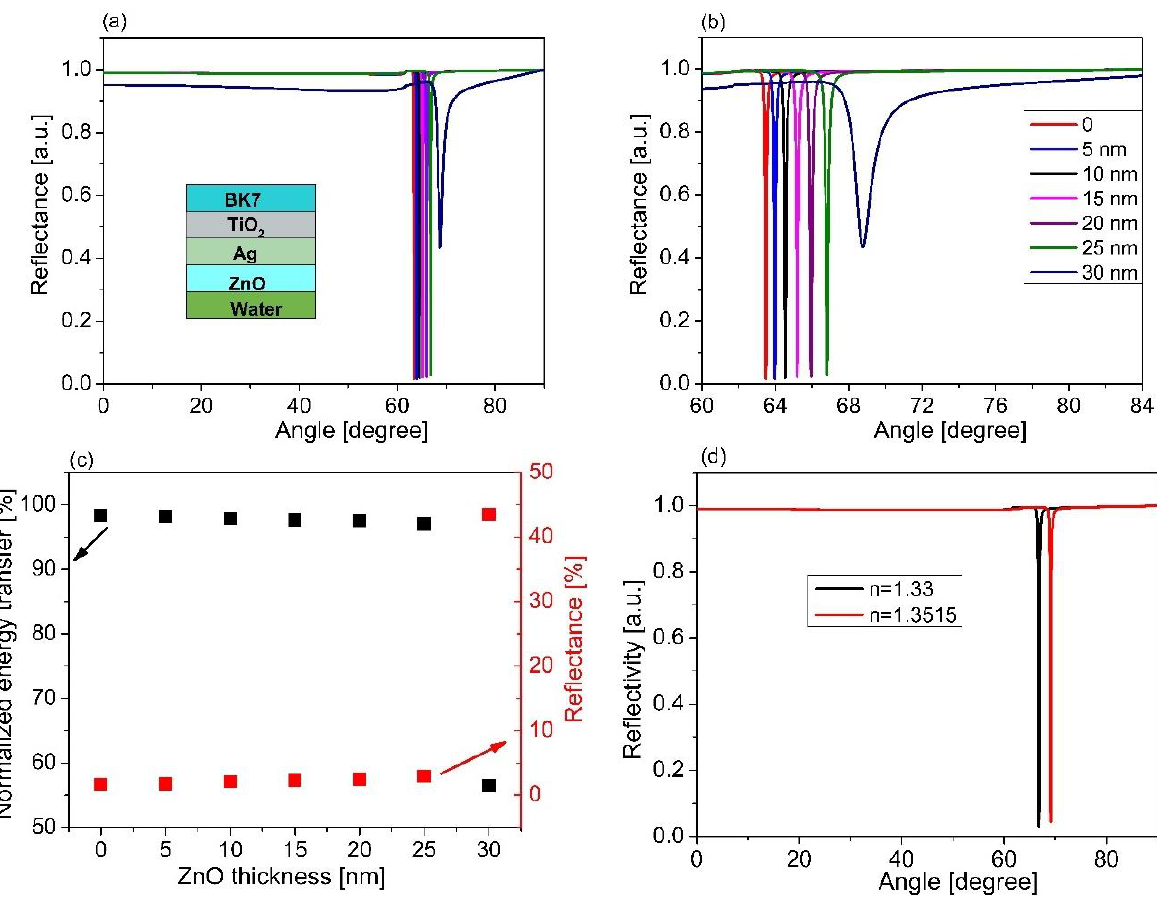
Figure 7. SPR spectra for varying thicknesses of ZnO based on the sensor structure of the BK7/TiO 2 /Ag/ZnO/sensing medium; ( b ) magnified view of ( a ); ( c ) the relationship between energy transfer and the ZnO thickness; ( d ) the change in resonance for different RI of the sensing medium based on the sensor structure of BK7/TiO 2 (140 nm)/Ag (60 nm)/ZnO (25 nm).